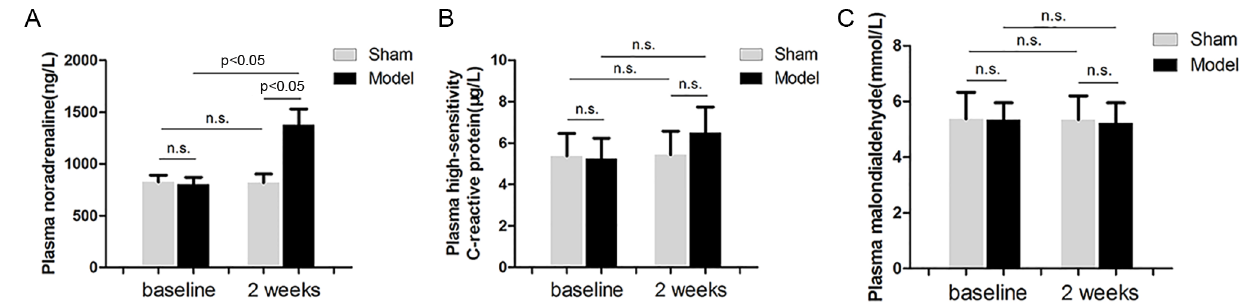
Figure 6. Effects of embolization versus sham operation on plasma noradrenaline (A), hs-CRP (B) and malondialdehyde (C) levels.